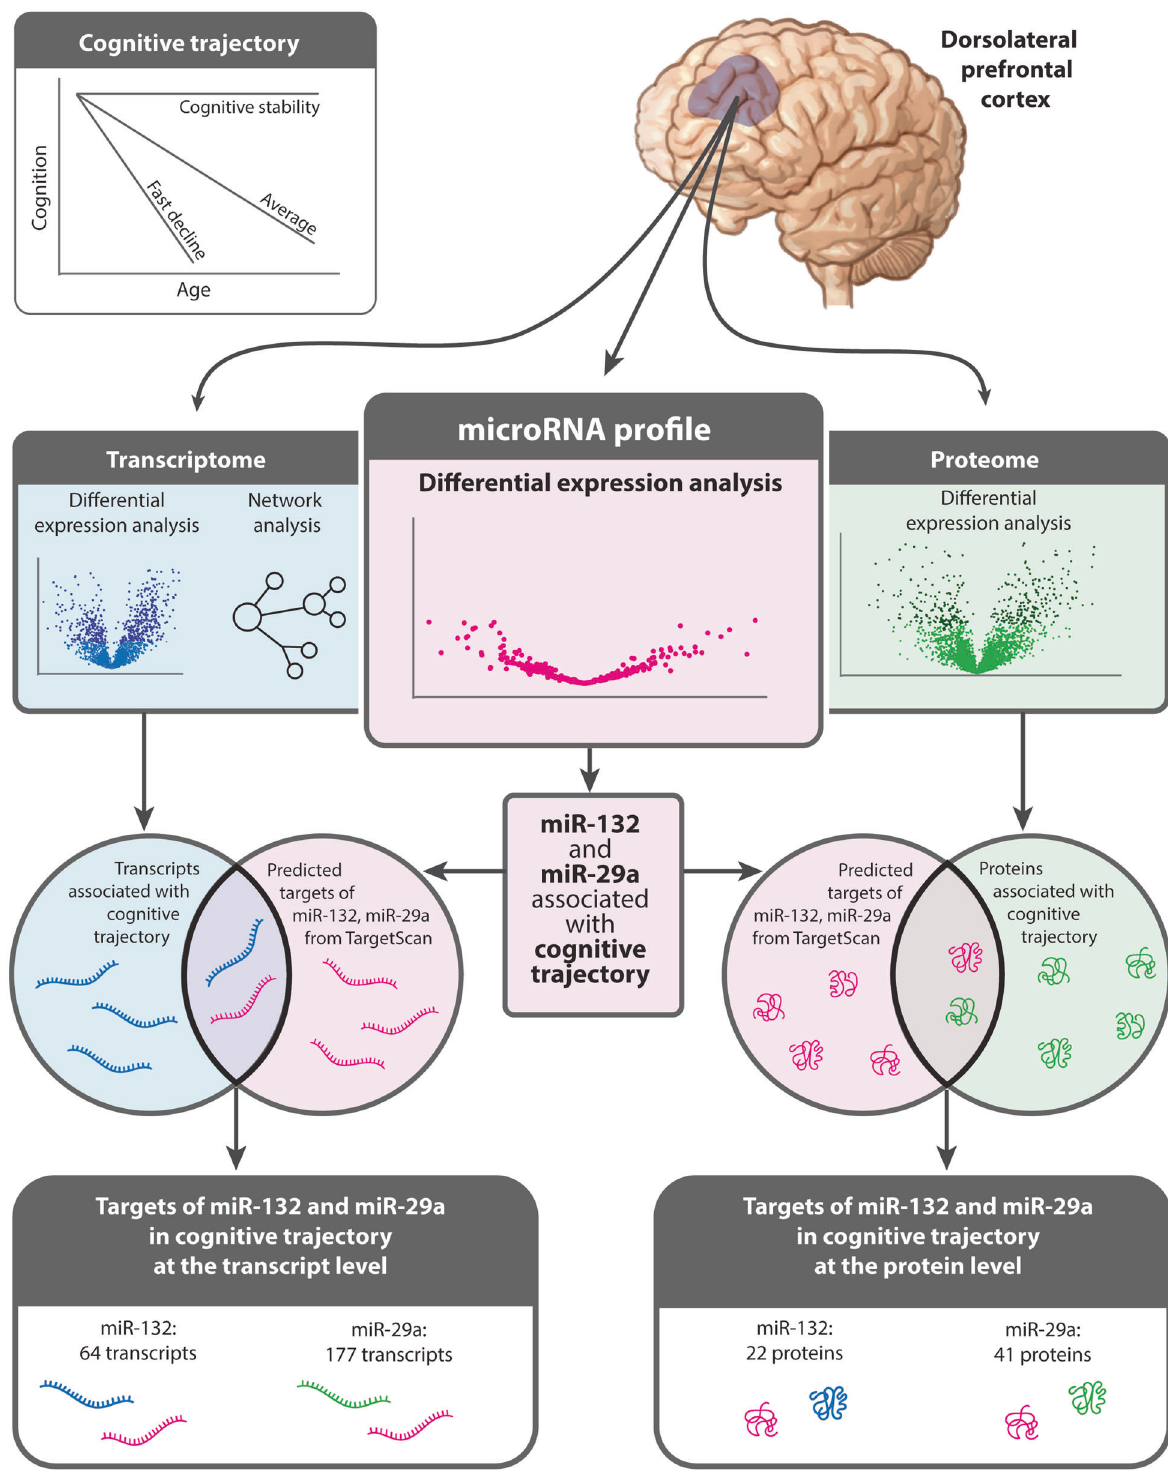
Fig. 1 Overview of the study design and fi ndings. Individual cognitive trajectories were estimated from annual cognitive testing scores in participants of the ROS/MAP, Banner, and BLSA cohorts, respectively. These participants donated their brains at death. In ROS/MAP, global microRNAs and transcriptomes were pro fi led from the dorsolateral prefrontal cortex (dlPFC). Likewise, in Banner and BLSA, proteomes were pro fi led from the dlPFC. A global miRNA association study of cognitive trajectory was performed followed by a transcriptome-wide and proteome-wide association studies of cognitive trajectory. Next, an integrative analysis was performed to identify downstream targets of the cognitive trajectory-associated miRNAs at the transcript and protein levels.